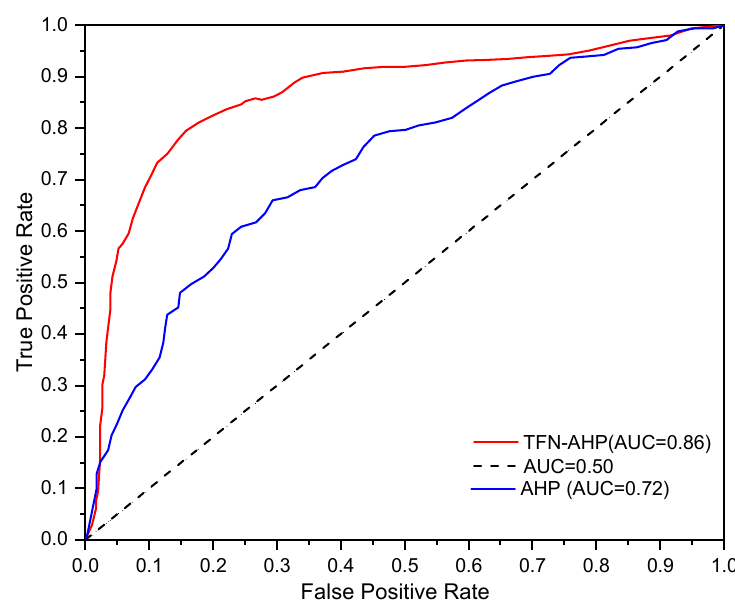
Figure 9. ROC curve validation for the obtained landslide susceptibility maps.